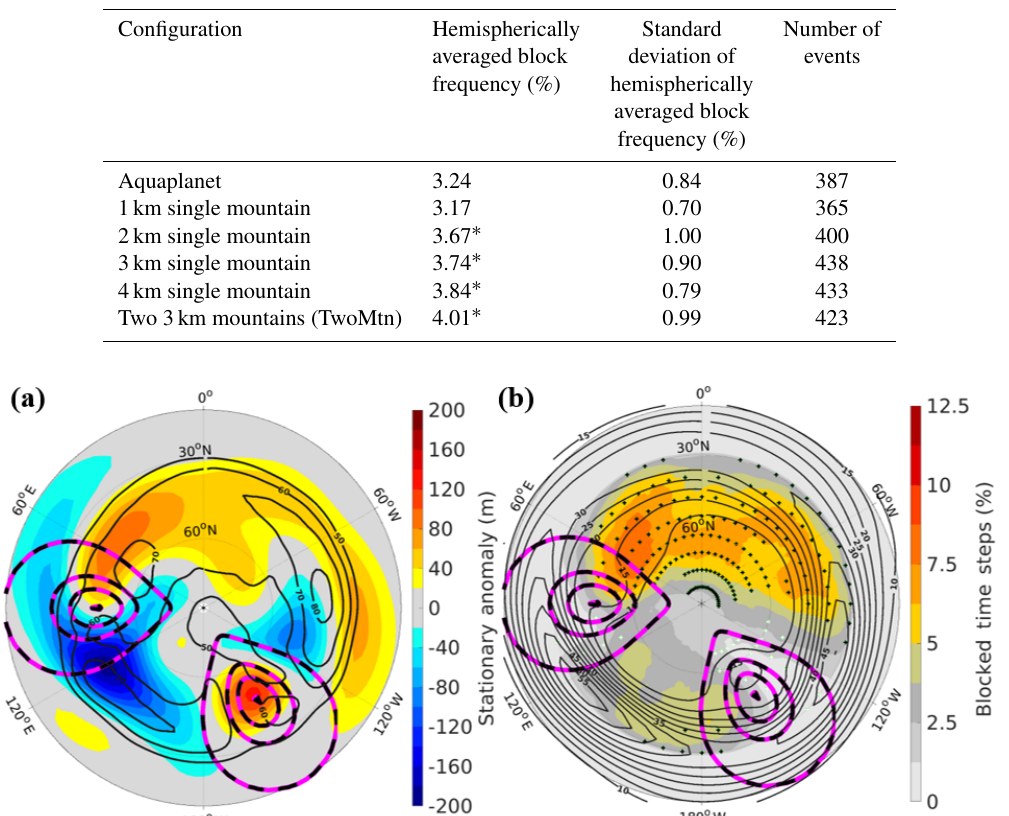
Table 2. Cool-season area-averaged block frequency and number of events in the idealized model integrations. Asterisks indicate values that are significantly different from the aquaplanet.